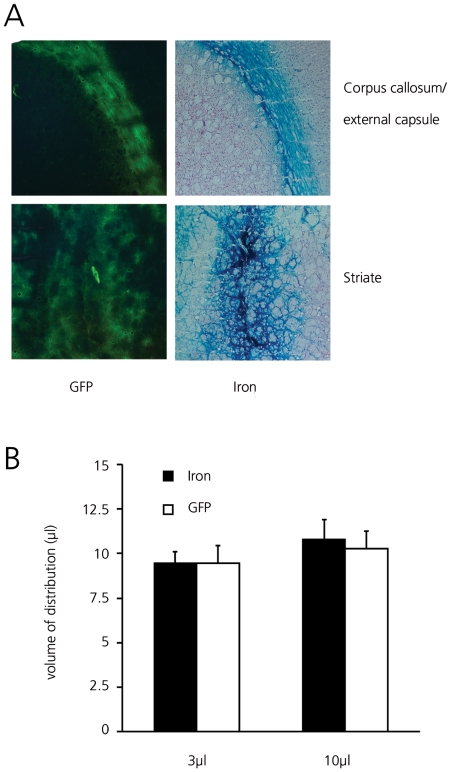
Co-infusion of SPIO and AdGFP in rat striate and corpus callosum.(A) Parallel 30 µm coronal sections three days after infusion. GFP and HE & iron stained sections showing GFP expression in external capsule and striate (left column) and corresponding iron distribution (right column). Original magnification 5×. (B) Vd of SPIO (black bars) and AdGFP (white bars) following 3 µl or 10 µl infusion into rat striate combined with AdGFP. No significant differences were noted. Average Vd ± SD are shown.